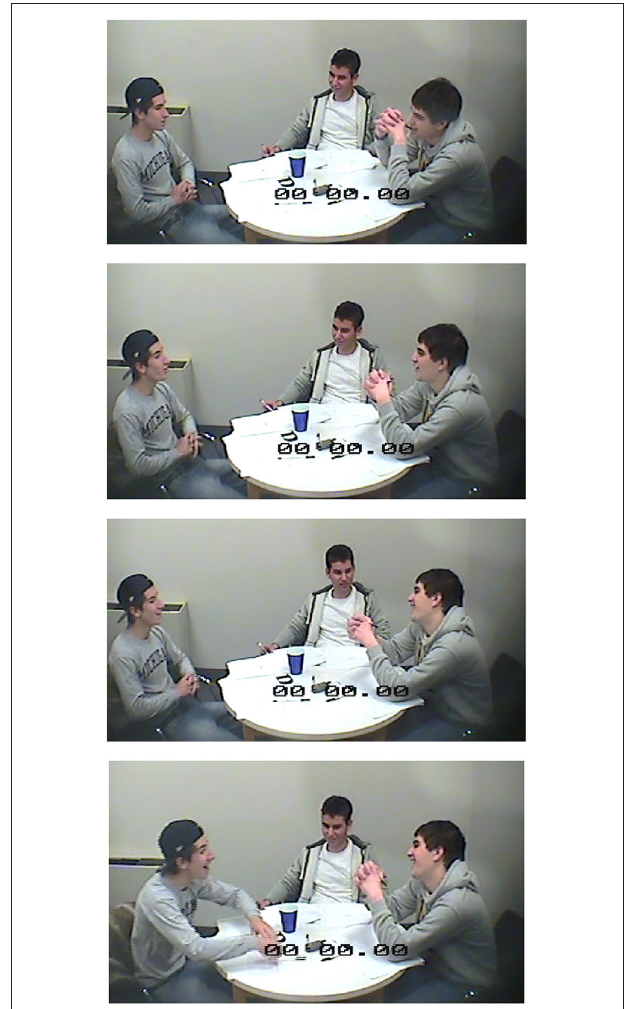
FIGURE 2 | Four-second sequence of screen grabs of self-managing team demonstrating more other- than self-focused attentional